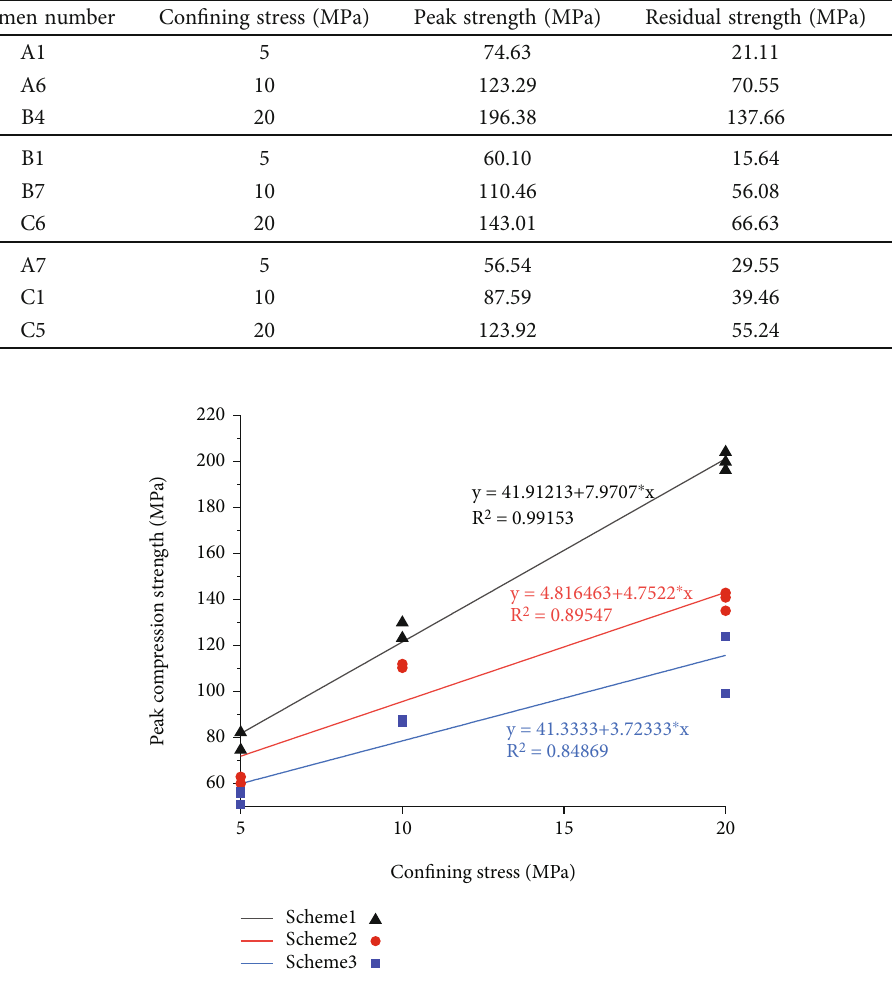
Figure 13: The peak compressive strength of each